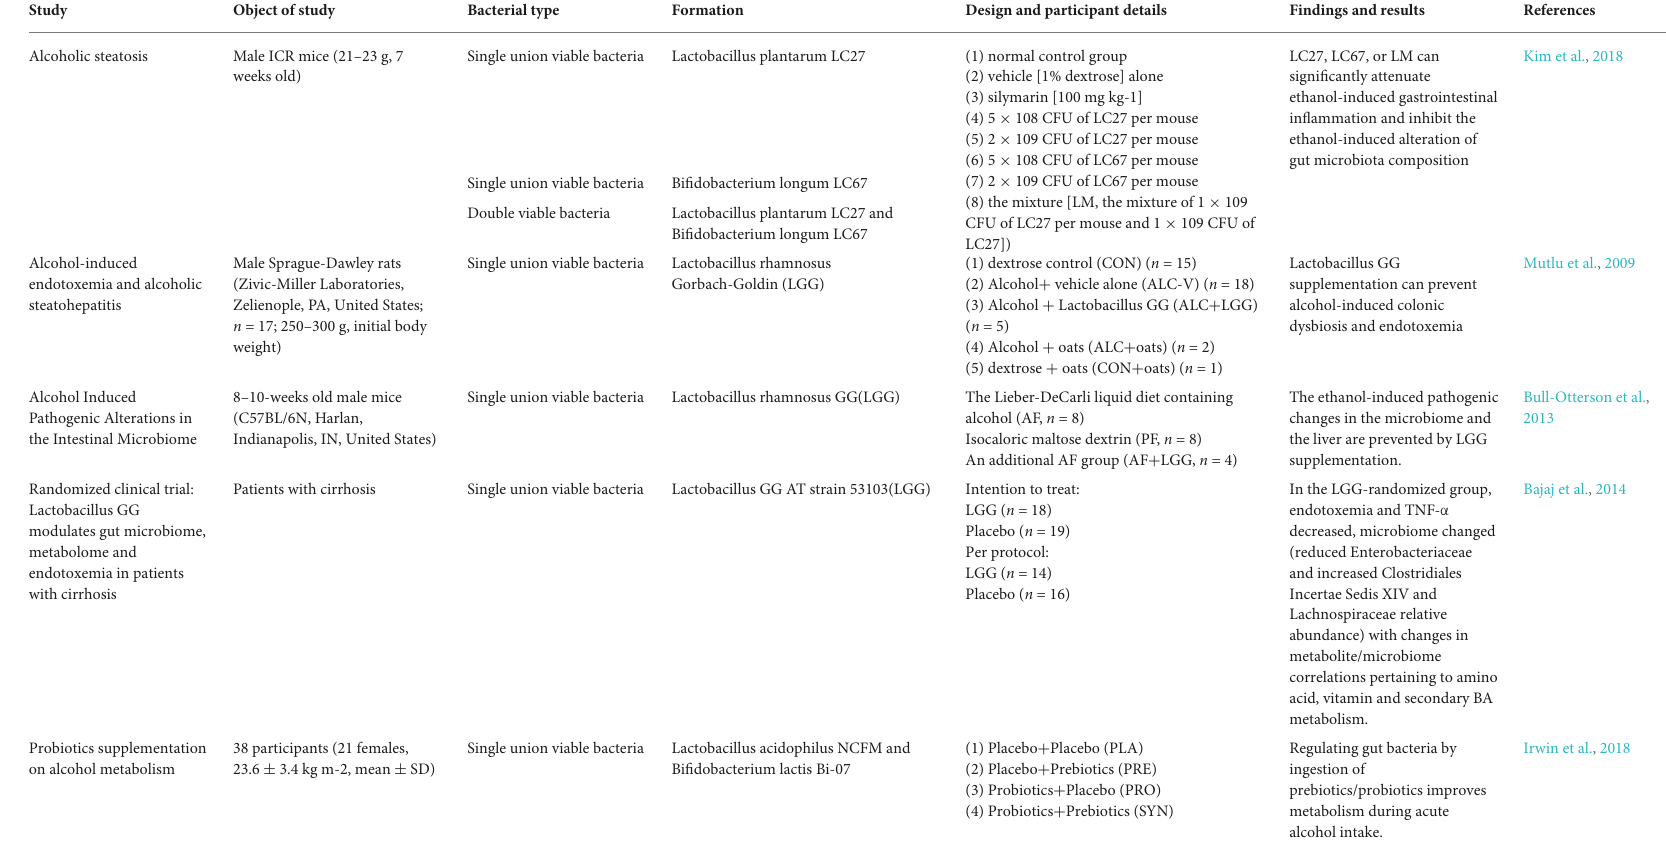
TABLE 2 Studies and results of gut microbiota